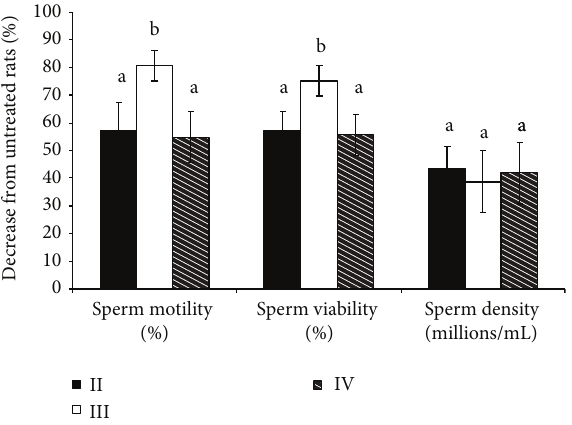
Figure2:Percentreductionsinvaluesofdifferentspermparameters in groups of rats treated with triptolide from that of untreated